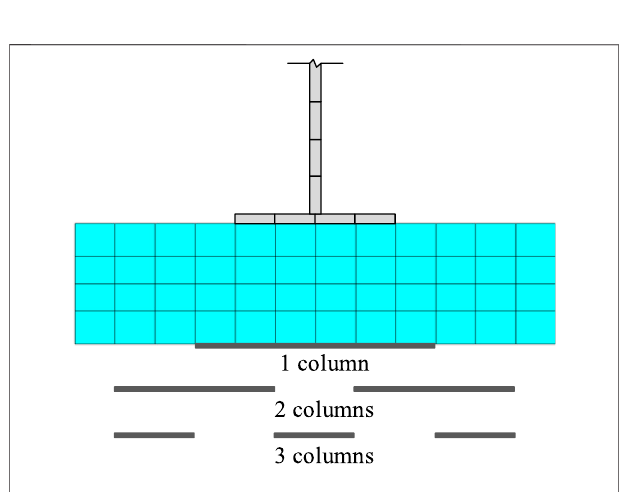
FIGURE 13 | Arrangement of the CFRP with different positions.